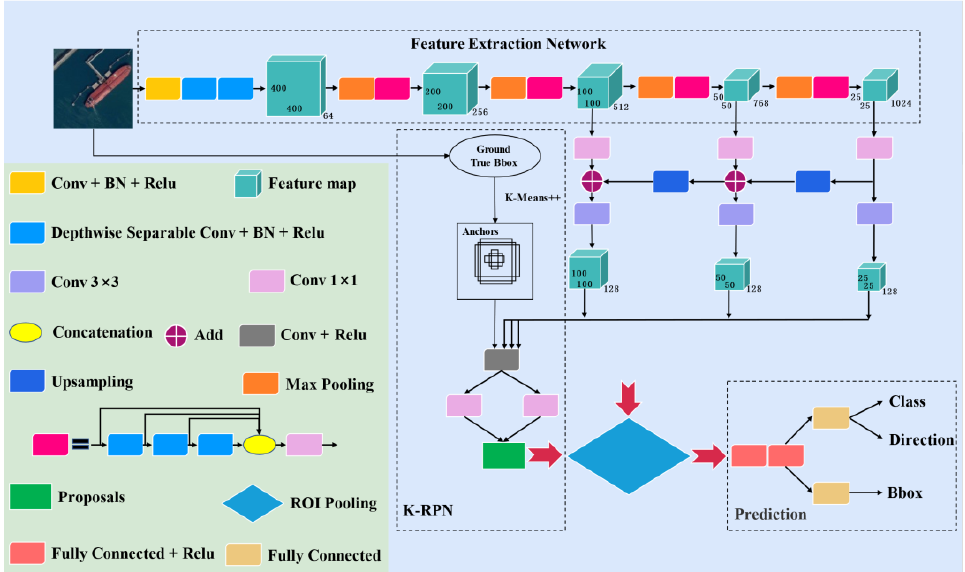
Figure 2. The overall model